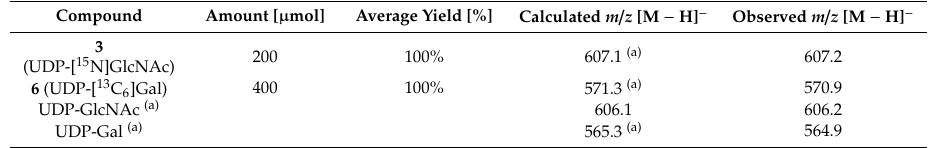
Table 1. Analysis of the synthesized nucleotide sugars compounds 3 and 6 by capillary electrophoresis with UV detection (CE-UV) and electrospray ionization mass spectrometry